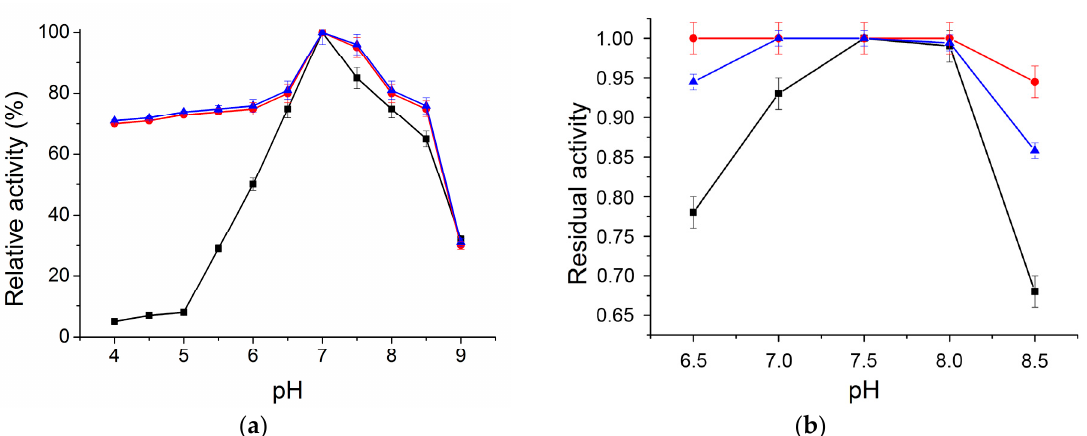
Figure 2. Influence of pH on ( a ) activity and ( b ) stability of free L -arabinose ( D -galactose) isomerase (LAI) and insoluble derivatives. ■ native enzyme; ▲ LAI-Eupergit C derivative; ● LAI-Eupergit C 250 L derivative.